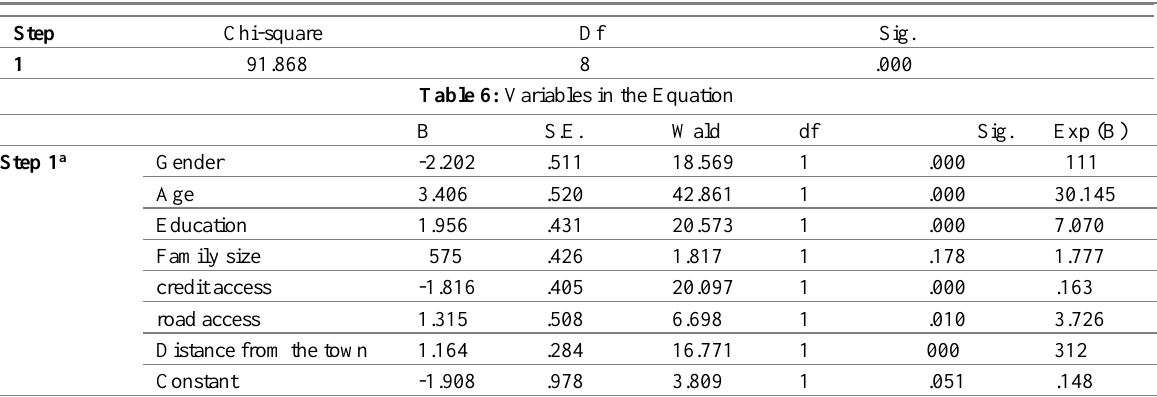
Table 6: Variables in the